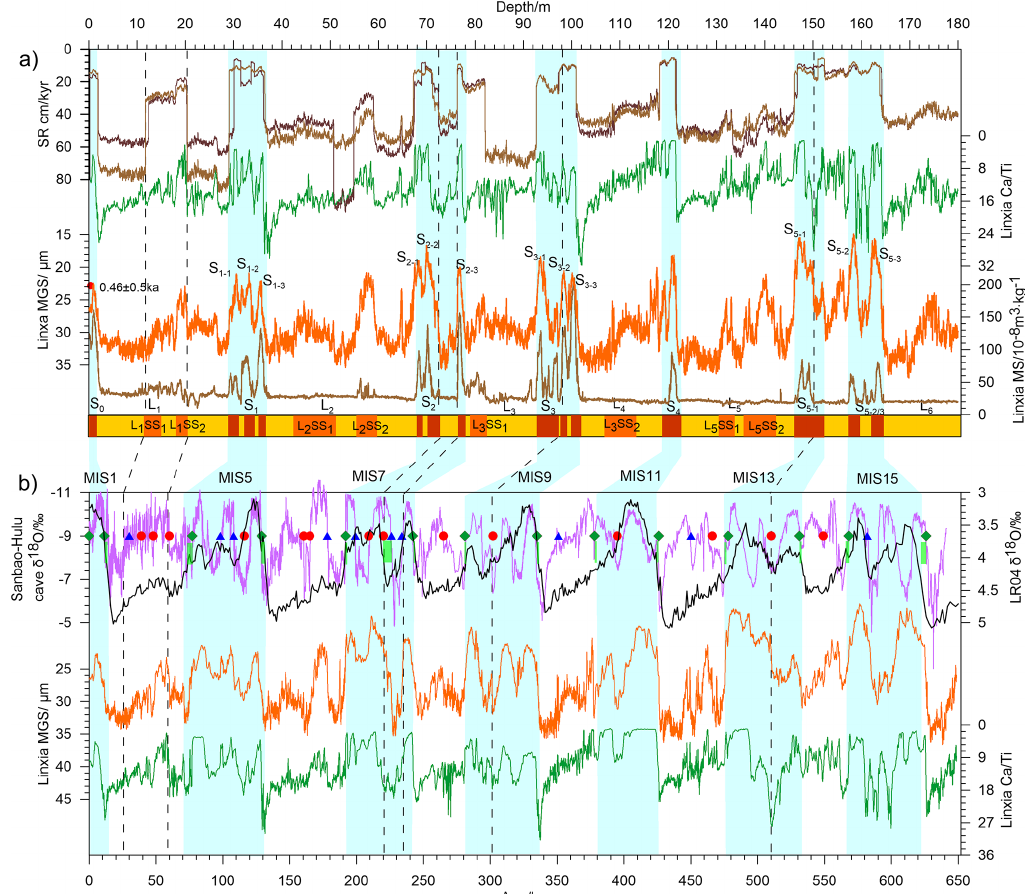
Figure 2. (a) Strata and down-core variations in mean grain size (MGS), magnetic susceptibility (MS), Ca / Ti and sedimentation rate against depth (brown in benthic δ 18 O age model and dark brown in speleothem δ 18 O age model). Brown red, orange and yellow rectangles represent paleosol layers, weakly pedogenic paleosols and loess layers, respectively. The timing of dashed lines and glacial–interglacial transitions is control points of benthic δ 18 O chronology. (b) Variations in MGS, Ca / Ti over last 650kyr and age model of the Linxia loess section. Comparison of MGS and Ca / Ti in the Linxia section with Sanbao–Hulu (Cheng et al., 2016) and benthic δ 18 O stack (Lisiecki and Raymo, 2005). The dark brown squares, blue triangles and red dots represent the first (glacial–interglacial transition), second (precession cycles) and third (millennial-scale events) class age control points at the corresponding position of the cave record, respectively (Sun et al., 2021a). Light blue bands denote the interglacial times. The short green rectangles represent the age differences between the two age